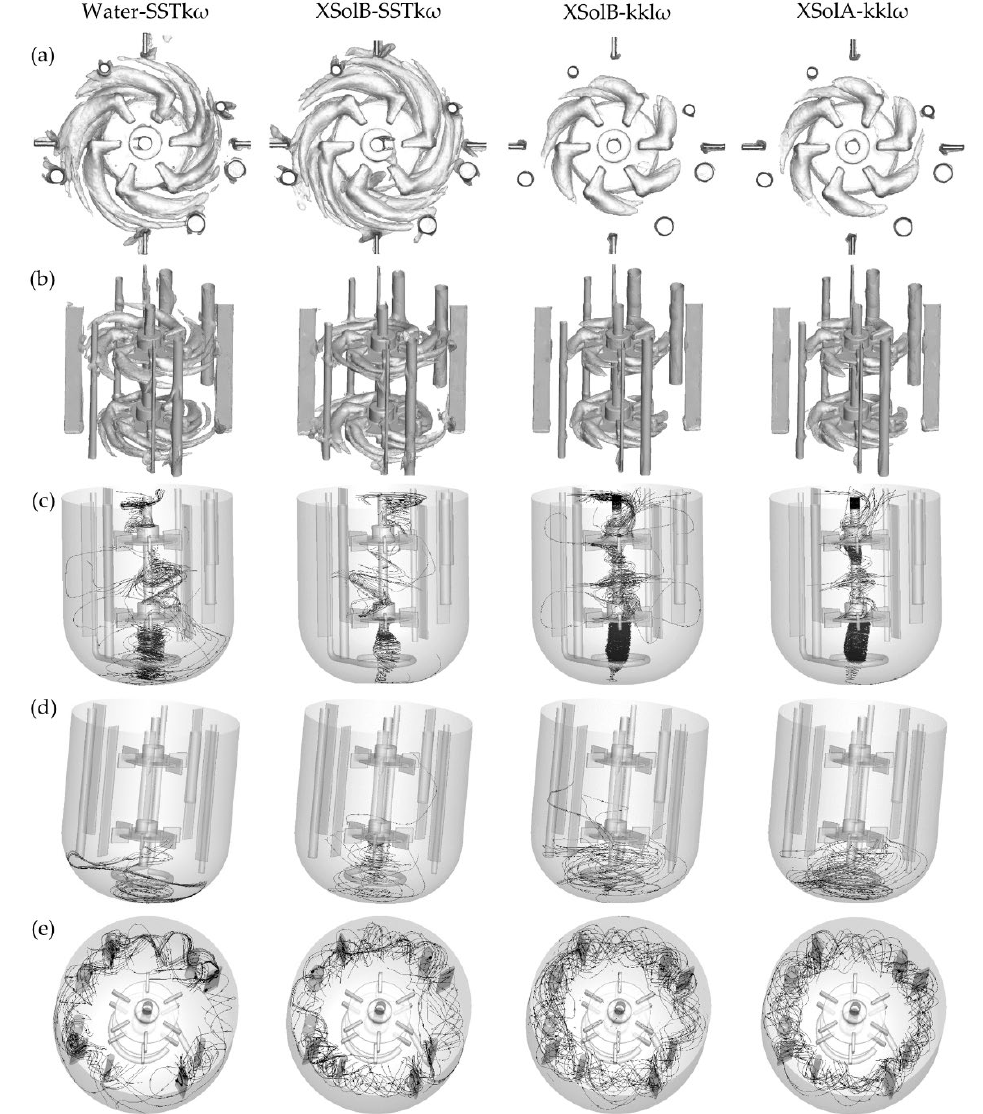
Figure 10. Visualization of the instantaneous vortical structures, after the simulation of 58 impeller turns. ( a ) Upper view of trailing vortices; ( b ) lateral view of trailing vortices; ( c ) precessional vortices around the axis; ( d ) Ekman pumping; and ( e ) vortices around probes, baffles and sparger pipe. Videos of the Ekman pumping vortex can be found in Supplementary Material.